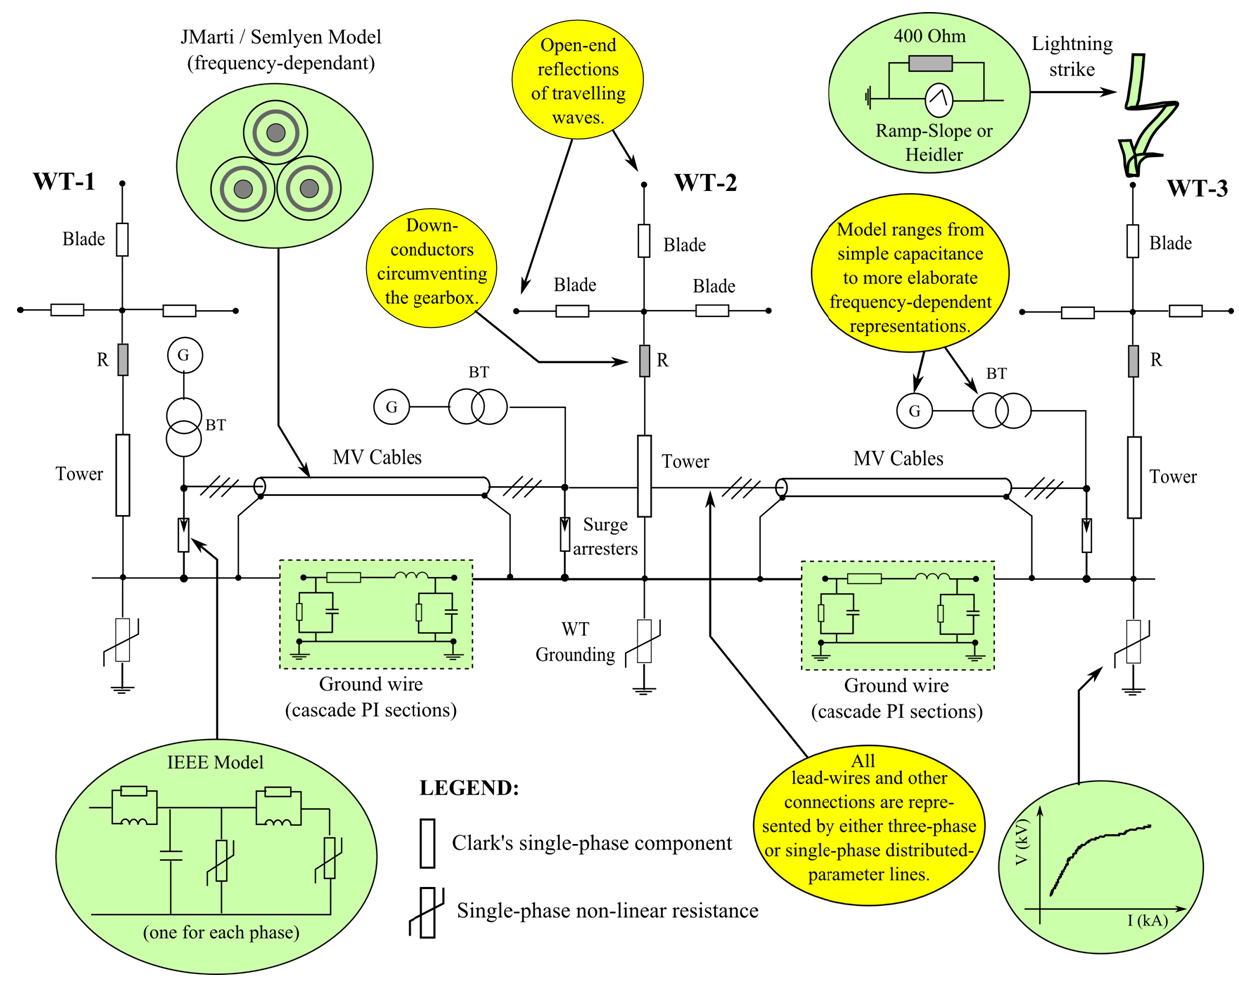
Figure 4. Graphical depiction of the EMTP model for the section of the wind farm electrical